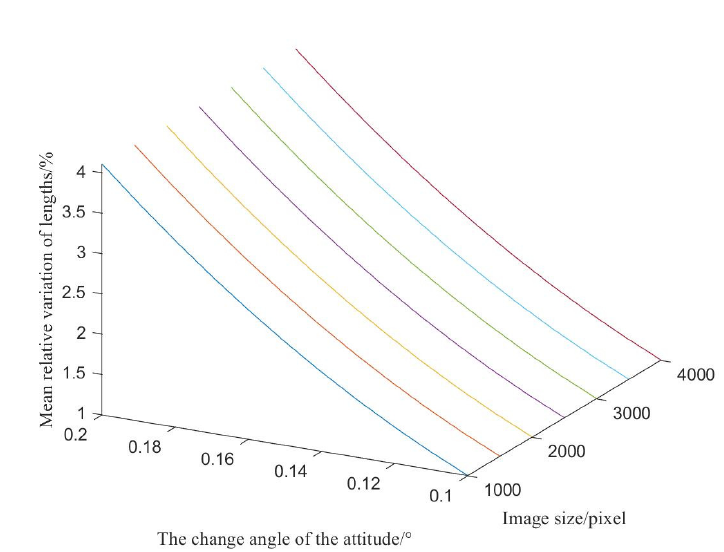
Figure 4. The range of the relative variation in